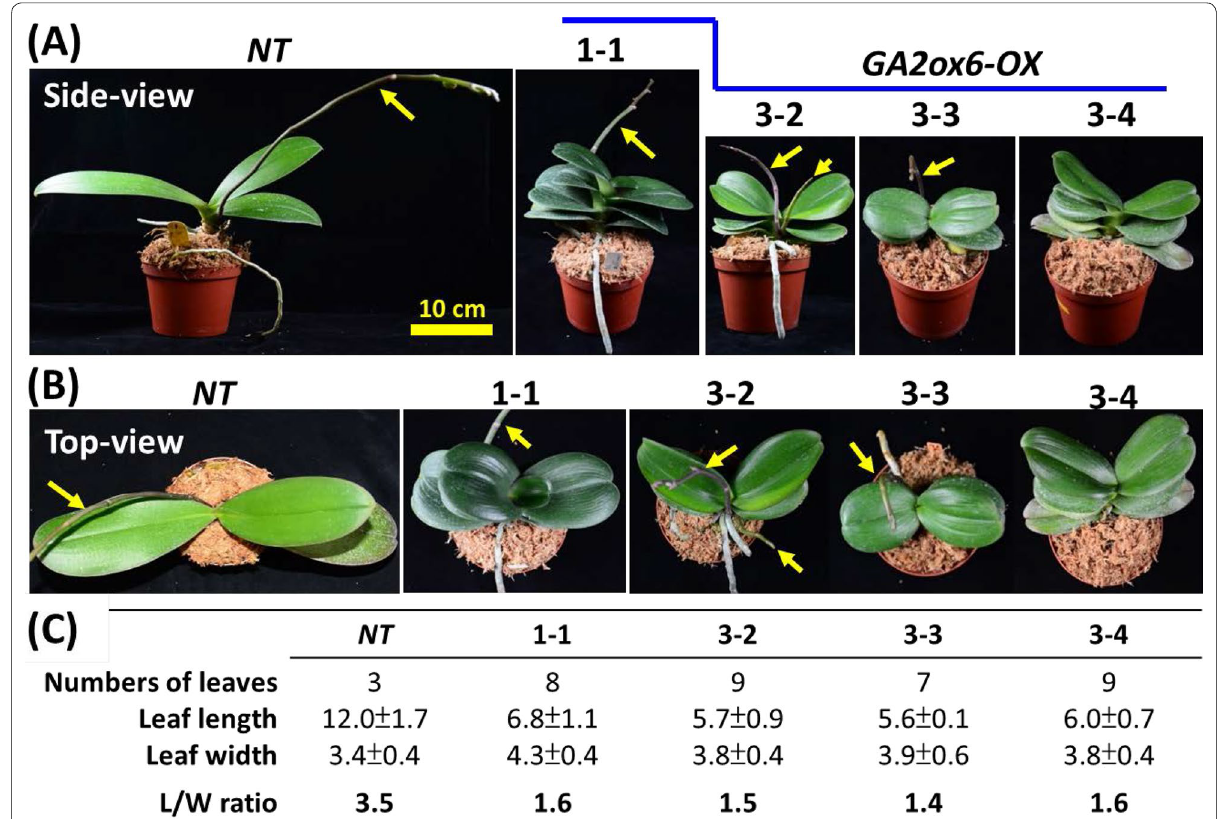
Fig. 3 Phenotypic comparisons of the NT and GA2ox6 ‑ OX transgenic lines at the vegetative stage. Comparison of representative mature NT plants and four different GA2ox6 ‑ OX transgenic lines (#1‑1, #3‑2, #3‑3 and #3‑4) in side view ( a ) and top view ( b ). The numbers of leaves and the average leaf length, width and length/width ratio of each representative plant were measured for the NT and GA2ox6 ‑ OX transgenic lines ( c ), and the resulting data are shown below the pictures. The flower spikes are indicated by yellow arrows in the